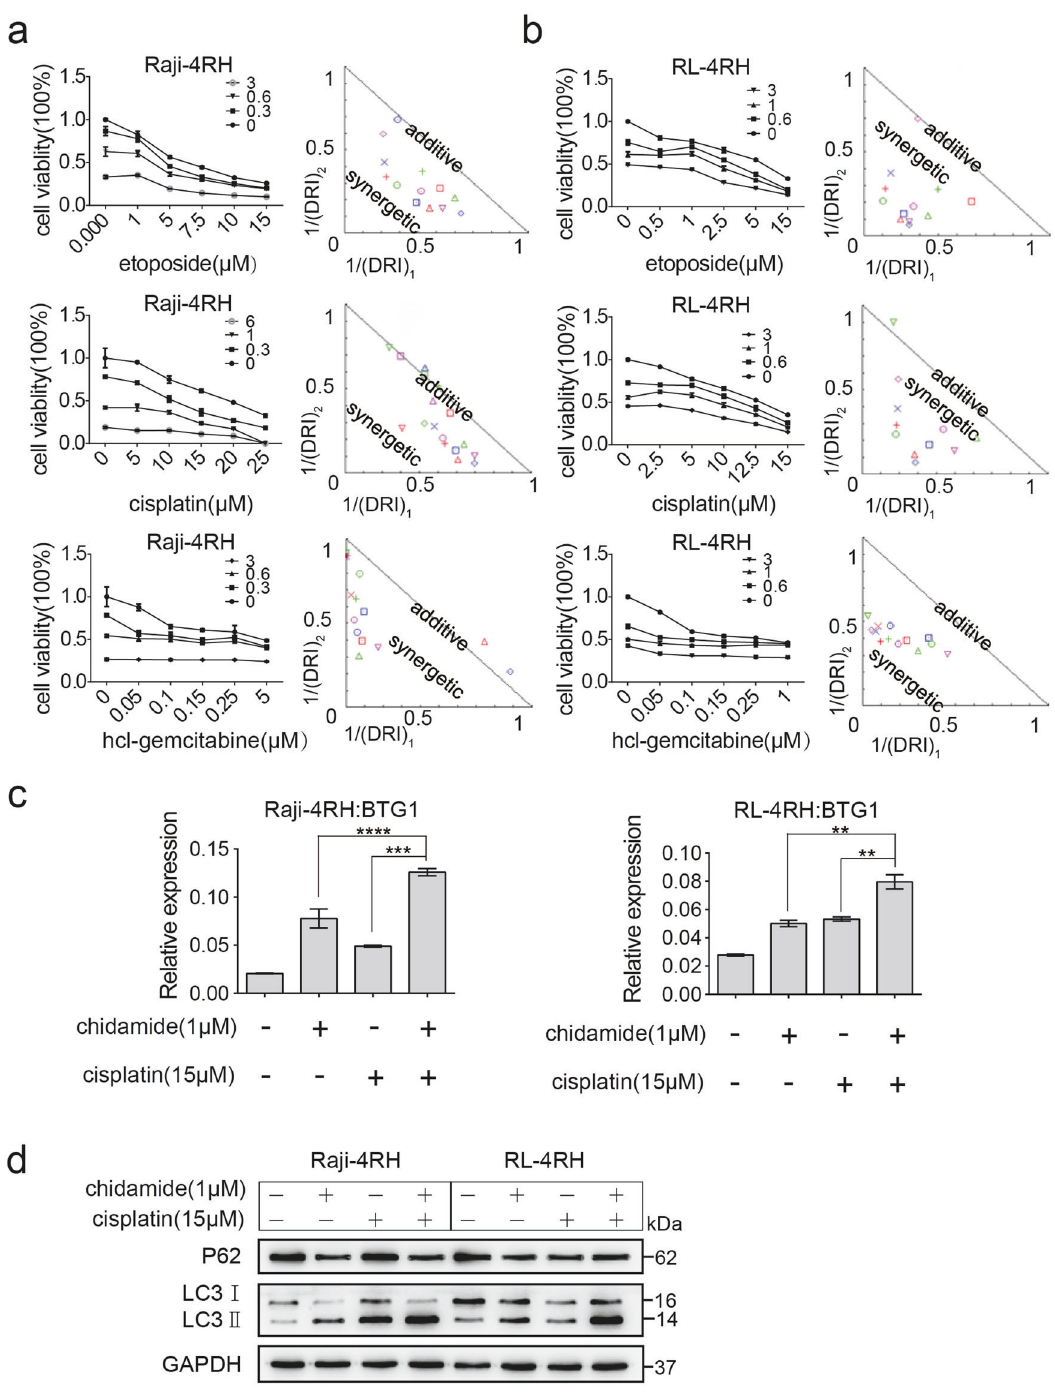
Fig. 7 Chidamide and chemotherapeutics were synergetic in vitro through congenerous upregulation of BTG1. a , b Raji-4RH ( a ) and RL- 4RH ( b ) were treated with the different combinations of chidamide and etoposide, cisplatin, hcl-gemcitabine for 72 h and cell viability were examined by using MTT assay. Cooperativity of chidamide and chemotherapeutics were calculated by Compusyn software. The normalized isobologram were shown. DRI: Dose-Reduction Index ( N = 3). c The expression of BTG1 in Raji-4RH and RL-4RH treated with DMSO, chidamide (1 μ M), cisplatin (15 μ M) or their combination for 48 h were examined by Q-PCR ( N = 3). d Changes of autophagy-related proteins in Raji-4RH and RL-4RH treated with DMSO, chidamide (1 μ M), cisplatin (15 μ M) or their combination for 48 h were examined by using Western blot analysis ( N = 3). For all graphs, data are presented as mean ± SD, * p < 0.05, ** p < 0.01, p < 0.005***, p < 0.001****. Statistical analysis was performed with a paired t